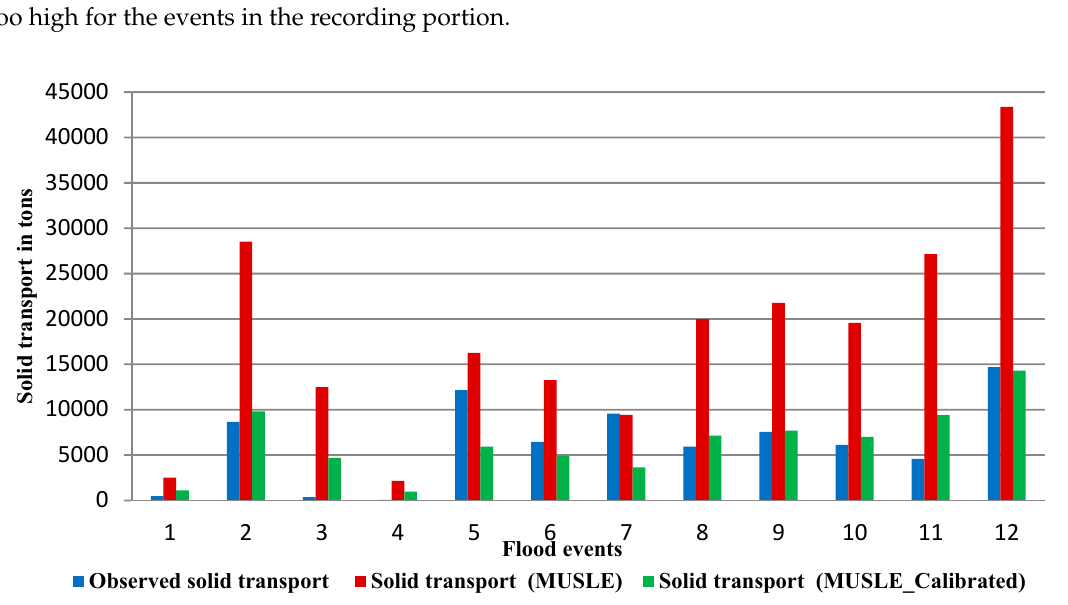
Figure 11. Comparison between MUSLE and observations at Sidi Mohamed Cherif on the Machraa.